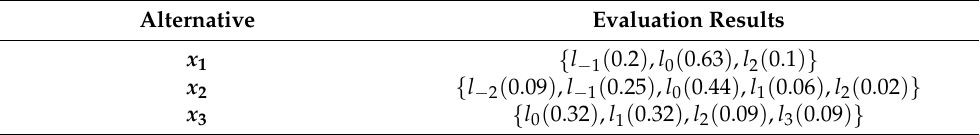
Table 4. Aggregate group decision